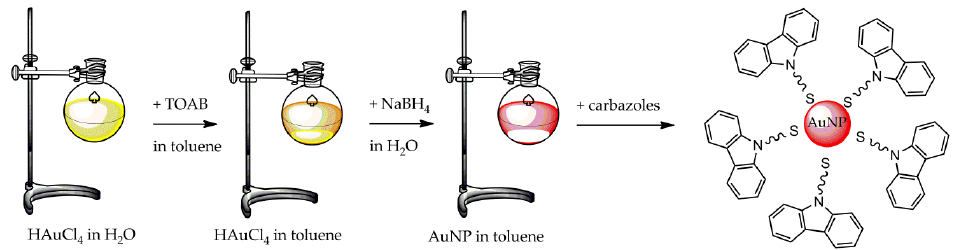
Figure 5. General procedure of synthesis of AuNP@N-thio-alkylcarbazoles